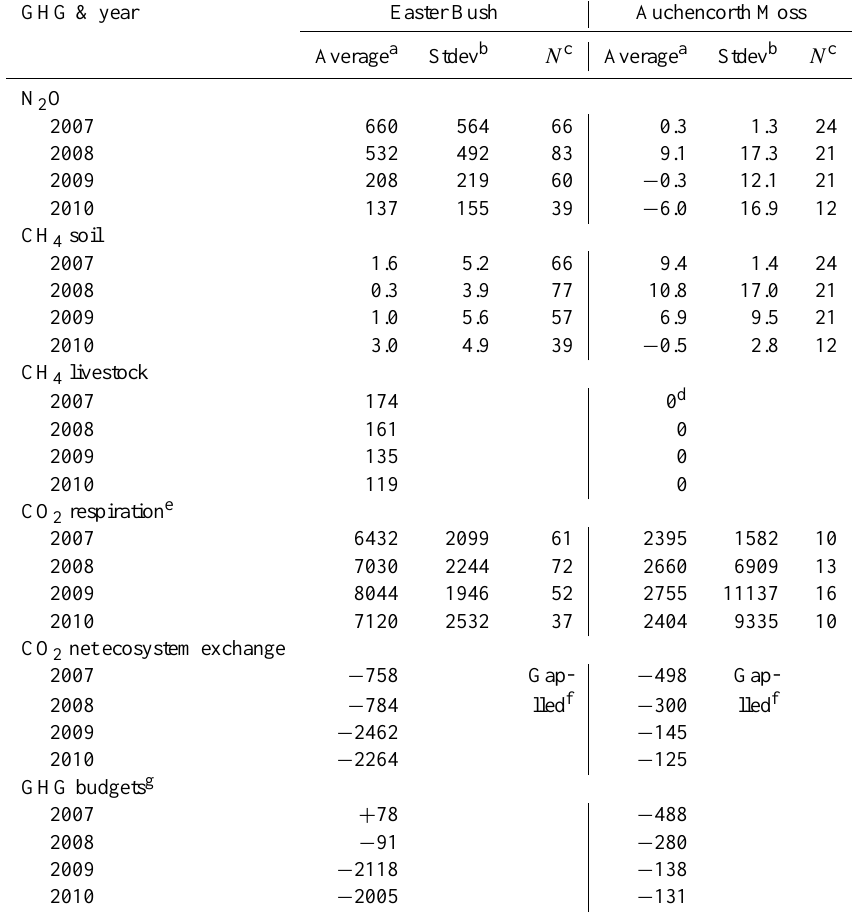
Table 2. Annual soil greenhouse gas (GHG) and NEE fluxes (gCO 2 the extensively grazed moorland “Auchencorth